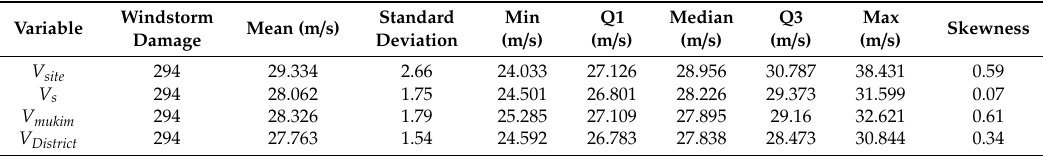
Table 7. Statistical analysis of windstorm damage in Peninsular Malaysia.